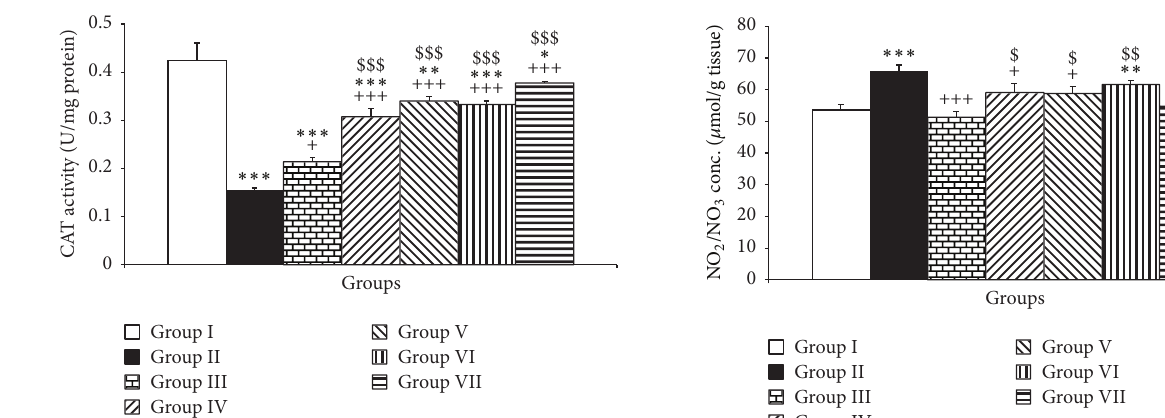
Figure 6: The effects of PTU, Vit E, pioglitazone, and rosiglita- zone on cerebellar NO metabolites. Data are presented as mean ± SEM; 𝑛 = 7 . ∗∗ 𝑃 < 0.01 and ∗∗∗ 𝑃 < 0.001 versus group I; + 𝑃 < 0.05 , ++ 𝑃 < 0.01 , and +++ 𝑃 < 0.001 versus group II; $ 𝑃 < 0.05 and $$ 𝑃 < 0.01 versus group III; # 𝑃 < 0.05 compared to group VI. The data from different treatment groups were compared by using one way ANOVA followed by post hoc LSD test. Group I